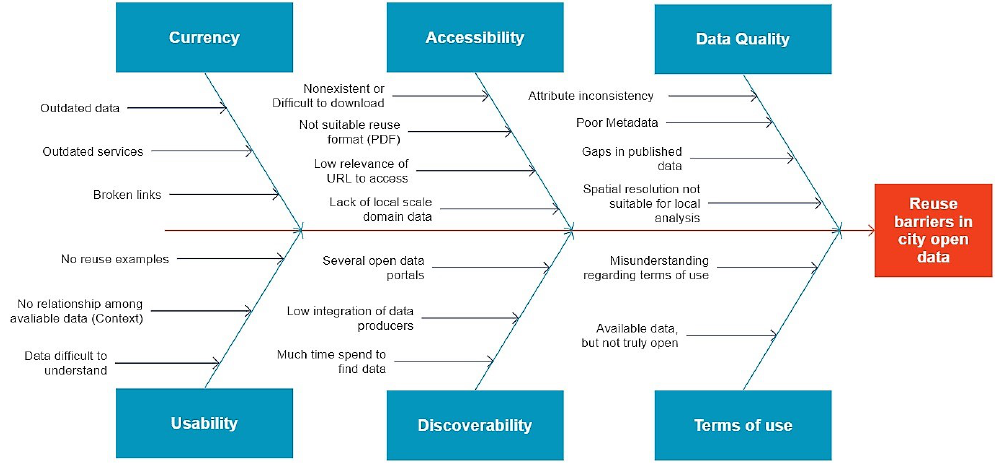
Figure 7. Fishbone diagram of barriers identified from a data user point of